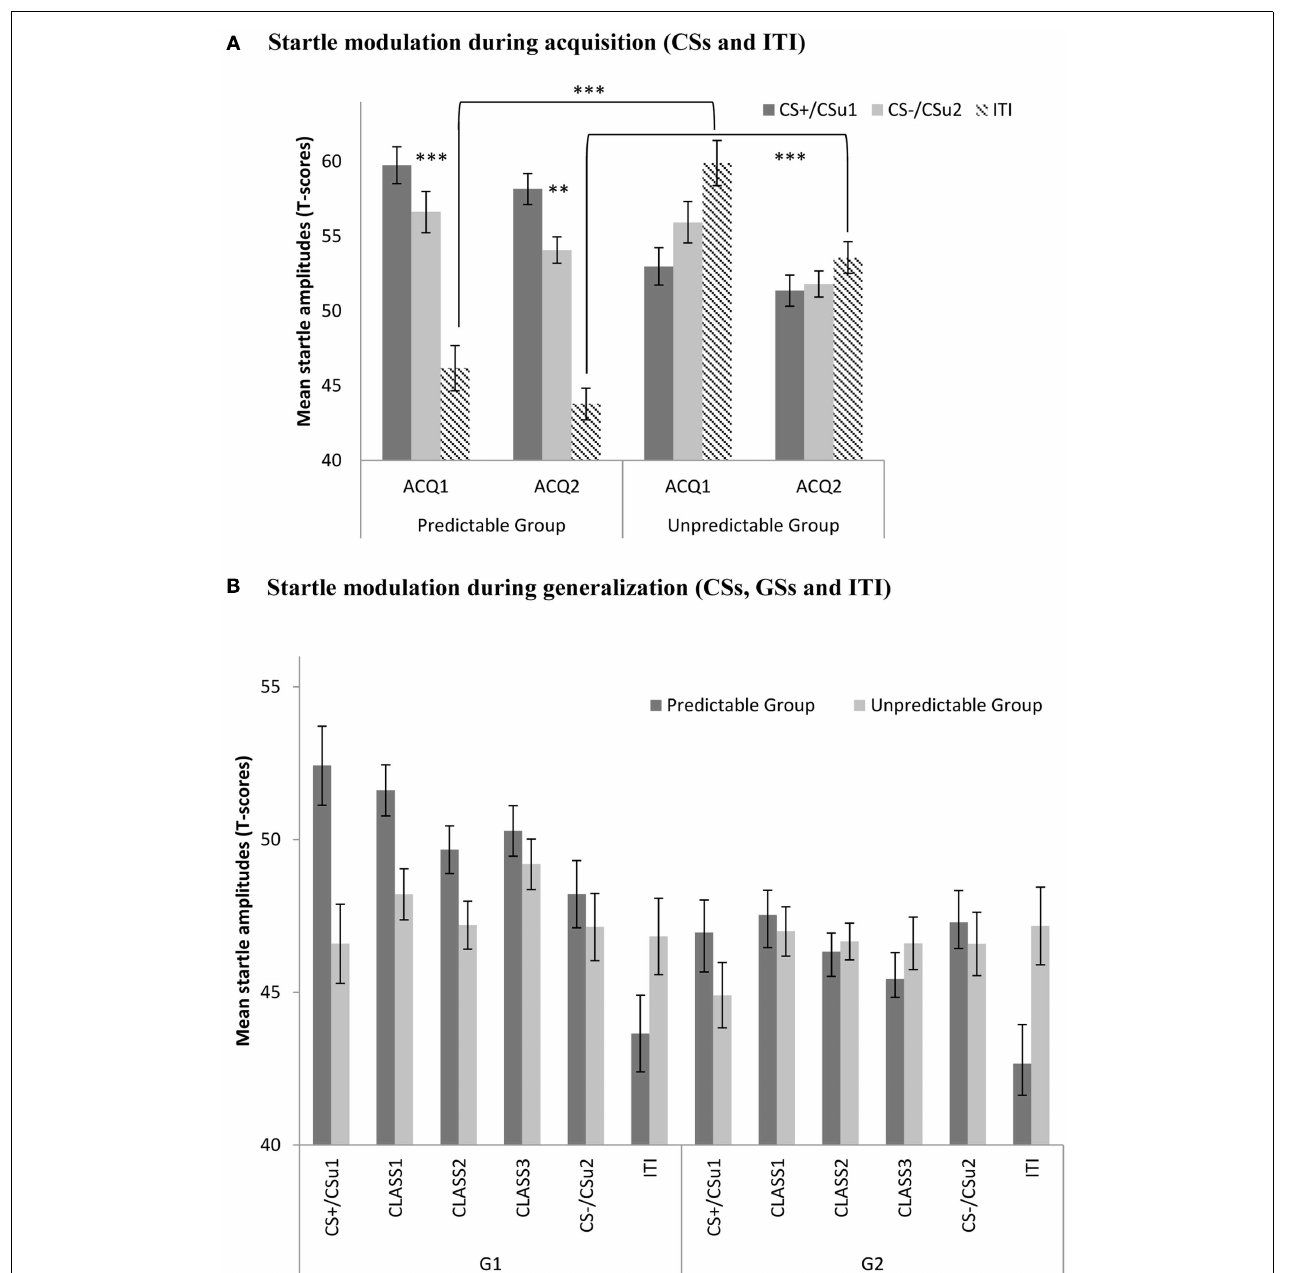
GS movements (CLASS1-3) and the ITI in the predictable and the unpredictable group during the generalization blocks (G1–G2). (A) Startle modulation during acquisition (CSs and ITI). (B) Startle modulation during generalization (CSs, GSs, and ITI).